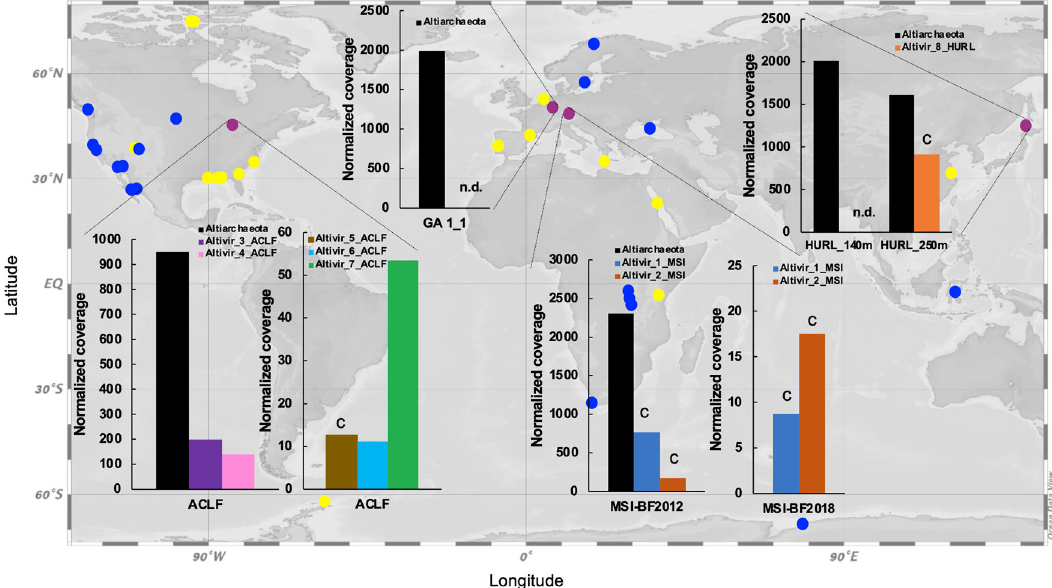
Fig. 1 Global distribution of abundant Altiarchaeota (group Alti-1) and their predicted viruses in Altiarchaeota hot spots. Distribution analysis is based on 16S rRNA gene sequencing (yellow dots) and the detection of hamus genes in metagenomes from IMG (blue and purple dots). Purple dots correspond to the four investigated sites of this study. Normalized host and virus coverage are given for the four subsurface habitats: Alpena County Library Fountain (ACLF, Michigan, USA), Horonobe Underground Research Laboratory (HURL, Japan), Mühlbacher Schwefelquelle, Isling (MSI, Germany), and Geyser Andernach (GA, Germany). Percent relative abundance of dominant Altiarchaeota compared to other community members is shown in Supplementary Table 1. Only Altivir_1_MSI and Altivir_2_MSI obtained from bio fi lm (BF) samples are shown. The letter C indicates circular genomes. n.d. none detected. World map has been generated using Ocean Data View v.5.3.0 117 . Color explanation of bars representing normalized coverage: orange-red = Altivir_1_MSI (virus), blue = Altivir_2_MSI, purple = Altivir_3_ACLF, rose = Altivir_4_ACLF, brown = Altivir_5_ACLF, light blue = Altivir_6_ACLF, green = Altivir_7_ACLF, and black = Altiarchaeota